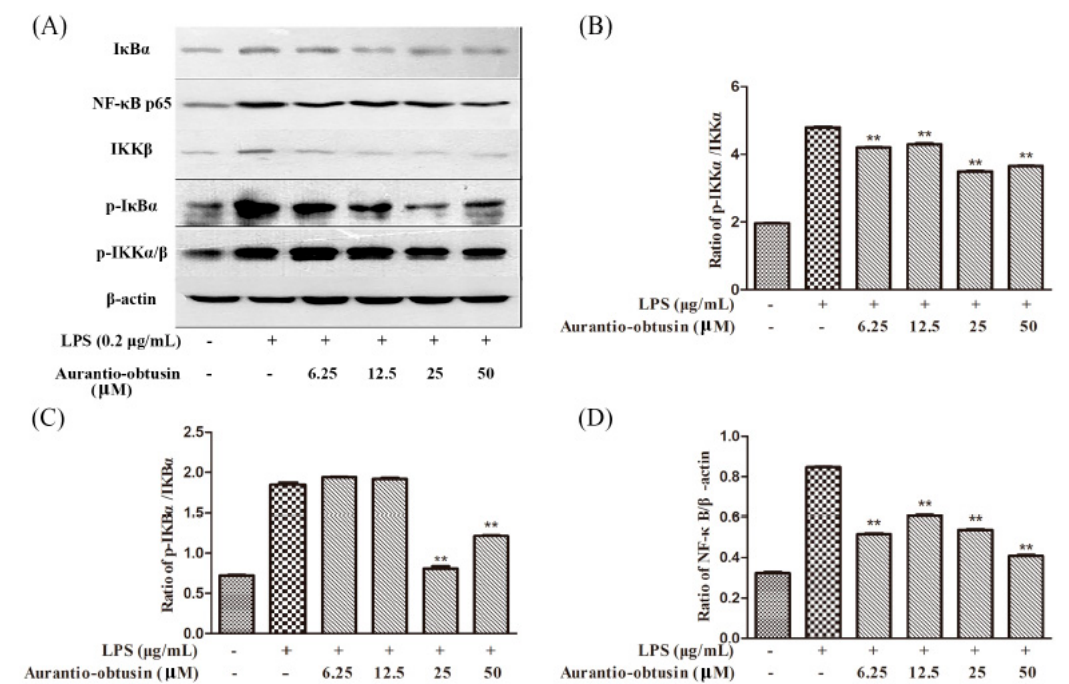
Figure 2. Effects of aurantio-obtusin on the expression of proteins associated with inhibition of NF- κ B in LPS-stimulated RAW264.7 mouse macrophages. RAW264.7 cells were pre-incubated with various concentrations (6.25–50 µ M) of aurantio-obstusin for 2 h, and stimulated with LPS (0.2 µ g/mL) for 12 h. The β -actin protein was used as the internal control. Expression of proteins associated with the inhibition of NF- κ B was detected by a western blot analysis ( A ). Comparison of the levels of phosphorylated protein relative to the levels of their non-phosphorylated counterparts in the grey scale: p-IKK α / IKK α ( B ) and p-IKB α / IKB α ( C ). Comparison of the levels of p65 relative to the levels of their actin counterparts in the grey scale ( D ). ** p < 0.01 represents significance when compared to LPS-only treated cells.